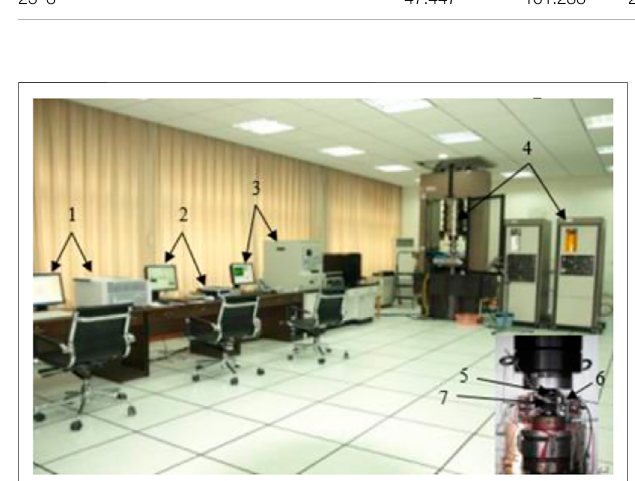
FIGURE 2 | Test system (1, Acoustic emission data acquisition and processing system; 2, MTS data acquisition and control system; 3, Ultrasonic collecting and processing system; 4, MTS loading system; 5, Acoustic emission probe; 6, Axial extensometer; 7, Transversal extensometer).